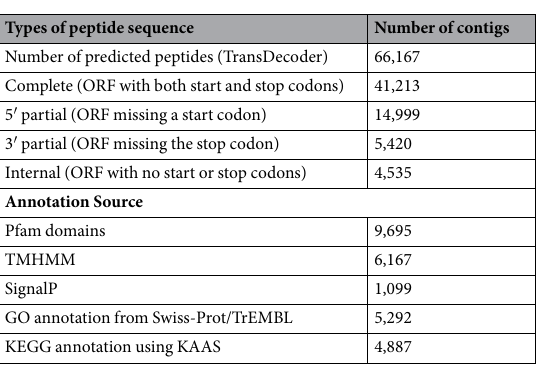
Table 5. Identification of predicted protein sequences using